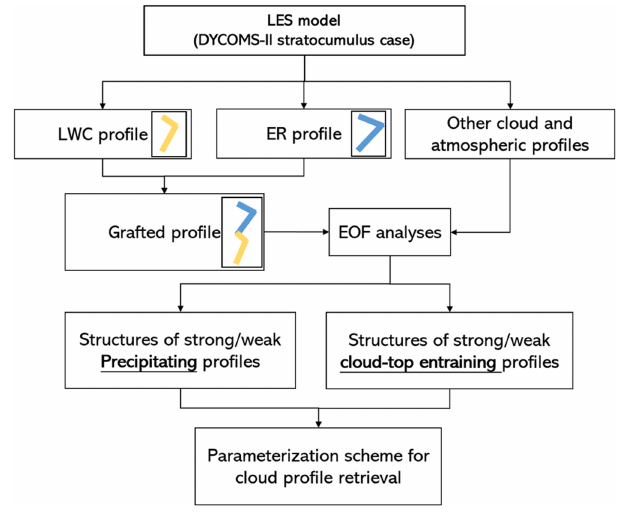
Figure 1. The flowchart for this